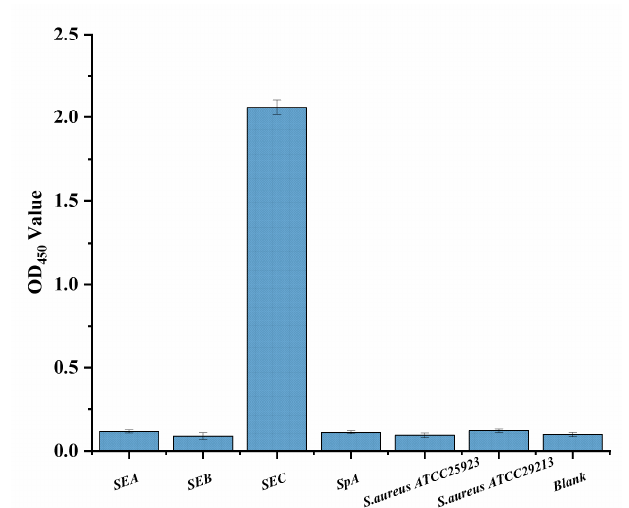
Figure 5. The specificity of the developed sandwich Nbs-ELISA for SEC detection. SEA, SEB, and SpA all displayed concentrations of 500 ng/mL. The S. aureus samples were used at equal concentrations of 10 7 CFU/mL, while PBS buffer was used as a blank control. The error bar was the standard deviation (SD) of the samples (n = 3).